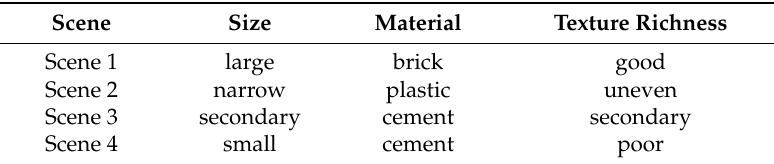
Table 2. Characteristics of test